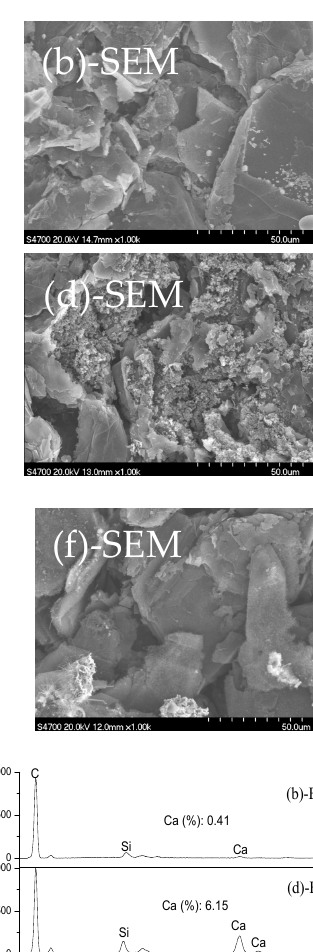
Figure 3. XRD analyses: ( a ) CaO (left) and ash-C (right) alone at 1500 °C; ( b ) CaO (left) and ash-C (right) when they were in close contact at 1500 °C; ( c ) CaO (left) and ash-C (right) when they were in close contact at 1700 °C.